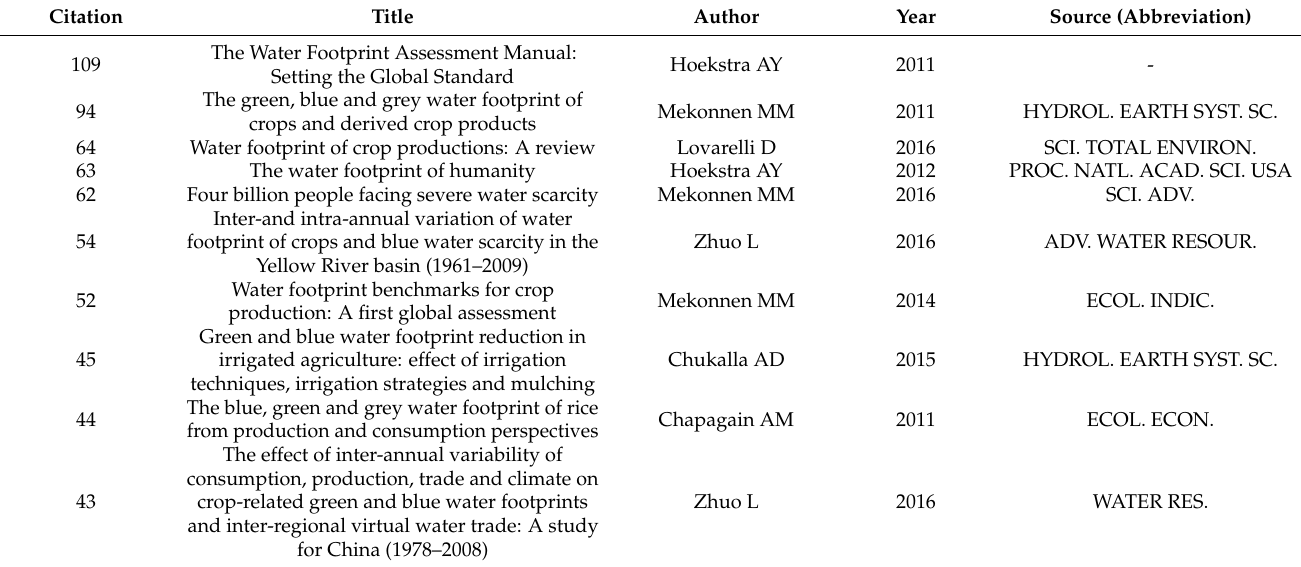
Table 1. The top-10 cited articles with co-citation